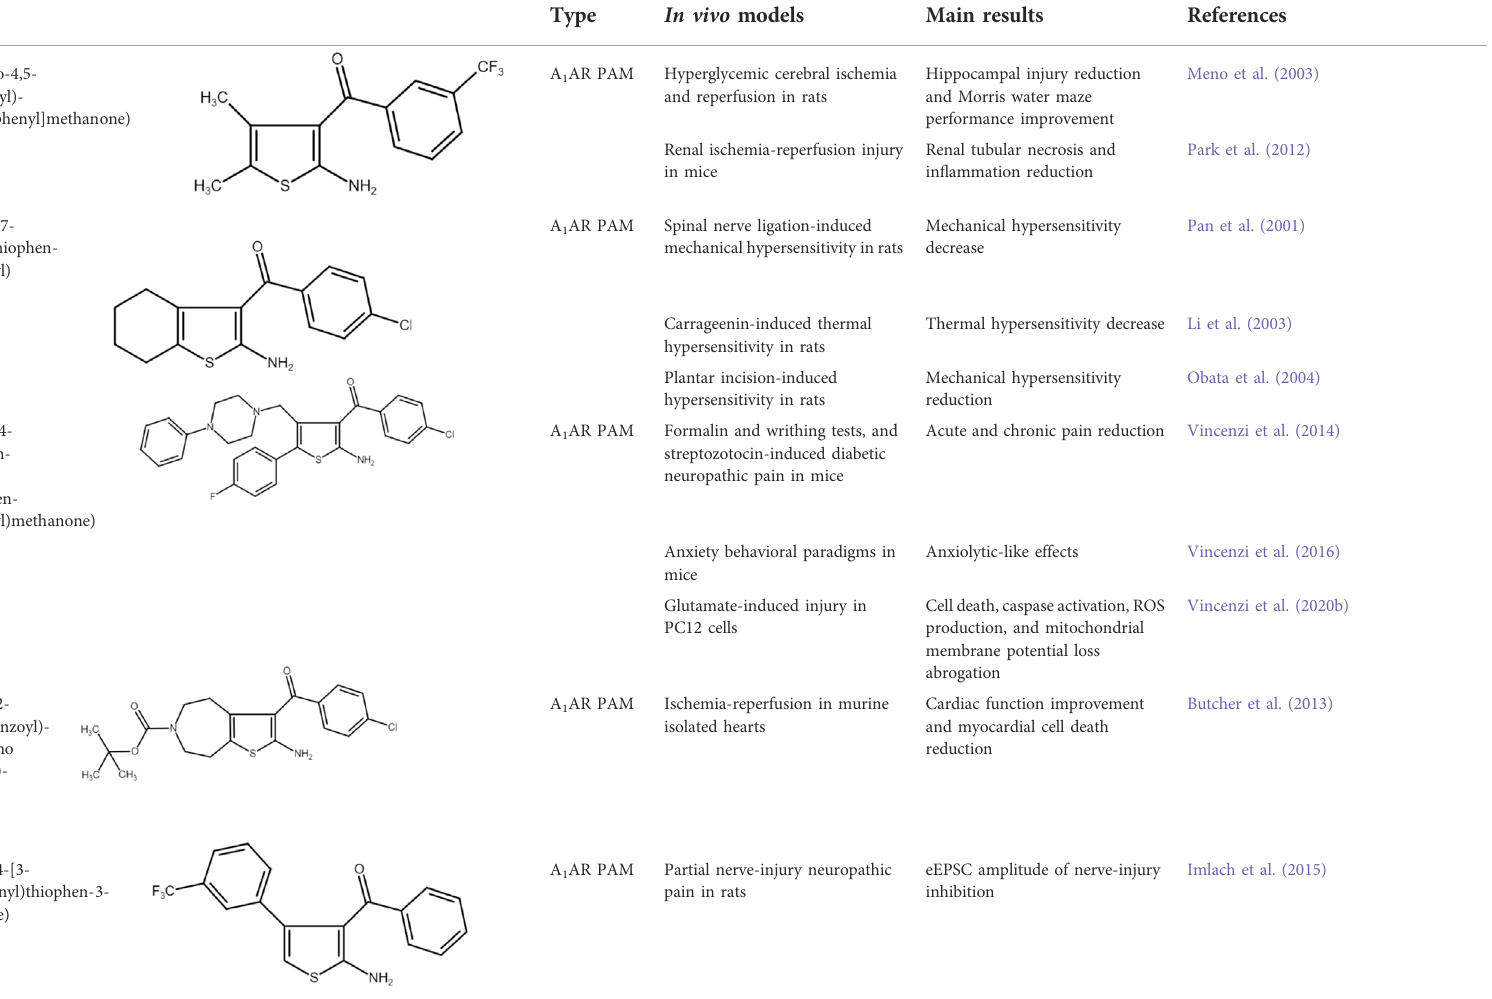
TABLE 1 Selected in vitro and in vivo studies on AR allosteric